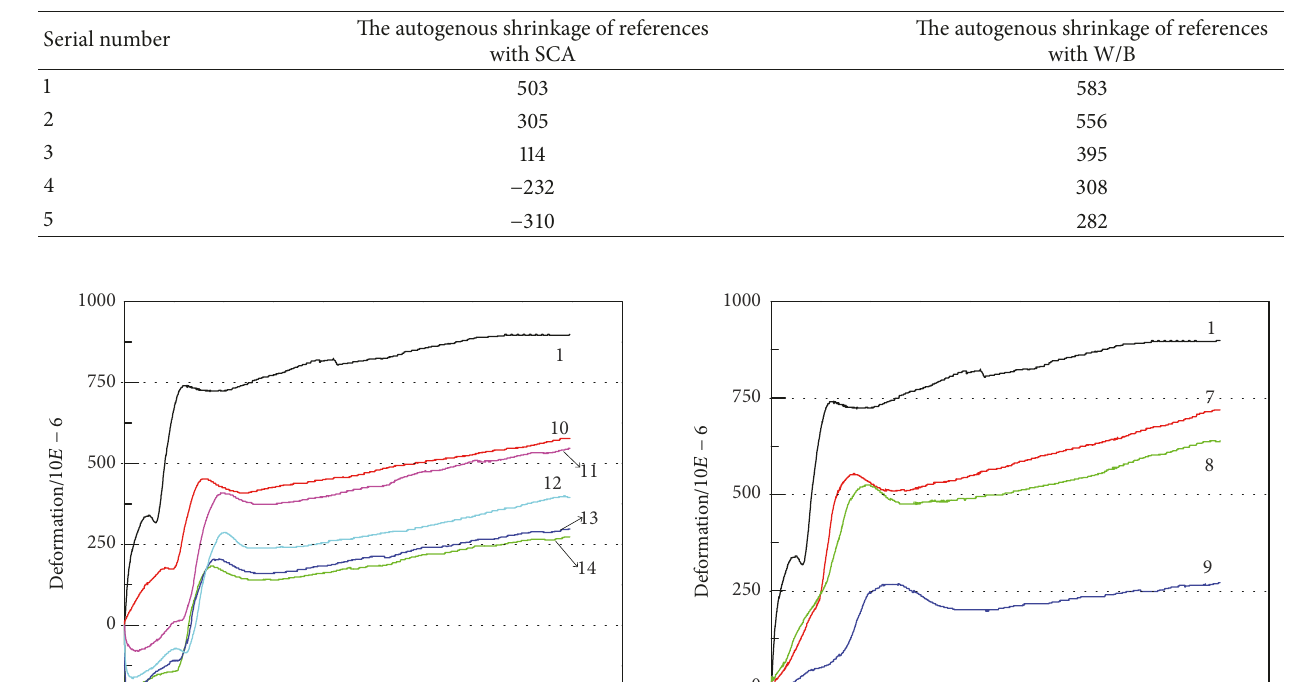
Table 4: The autogenous shrinkage deformation of references.